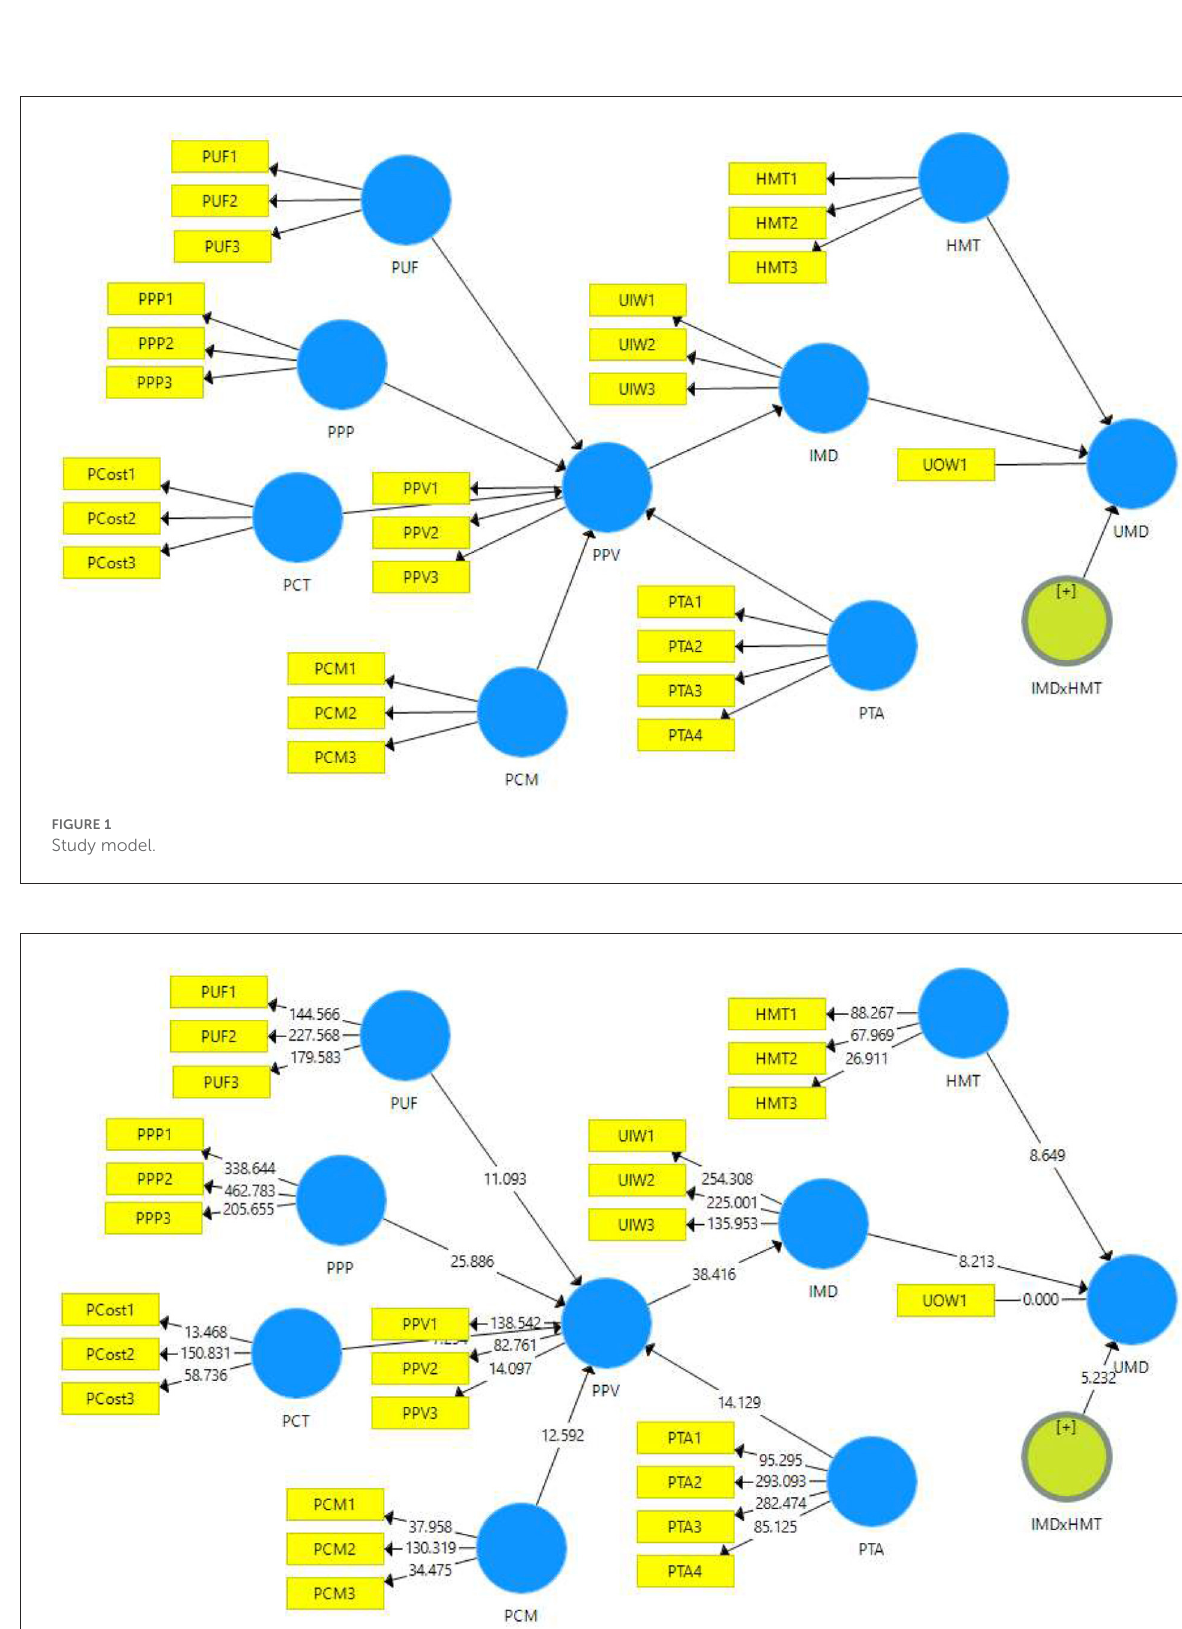
FIGURE2 Study model with PLS-SEM